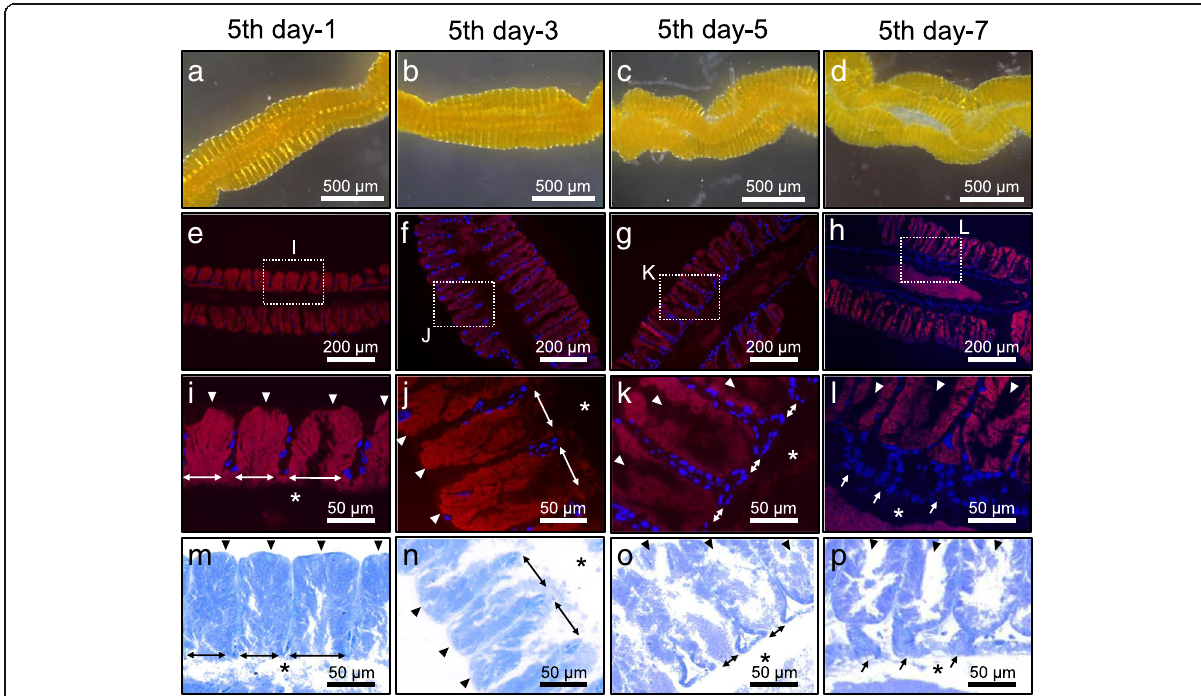
Fig. 6 Morphogenesis of the symbiotic organ at late developmental stages of P. stali . a – d Bright-field images of the symbiotic organs. e – h FISH visualization of the symbiotic bacteria in red on tissue sections of the symbiotic organ, where host ’ s nuclear DNA is counterstained in blue. i-l Magnified images of ( e-h ). m – p Adjacent tissue sections to i – l stained with toluidine blue. a , e , i , m Fifth instar nymph 1 day after molting. b , f , j , n Fifth instar nymph 3 days after molting. c , g , k , o Fifth instar nymph 5 days after molting. d , h , l , p Fifth instar nymph 7 days after molting. In i- p , arrowheads highlight the crypts, asterisks show the main tract, two-way arrows indicate the crypt openings to the main tract, and arrows show the pedicel-like structures formed with the crypt